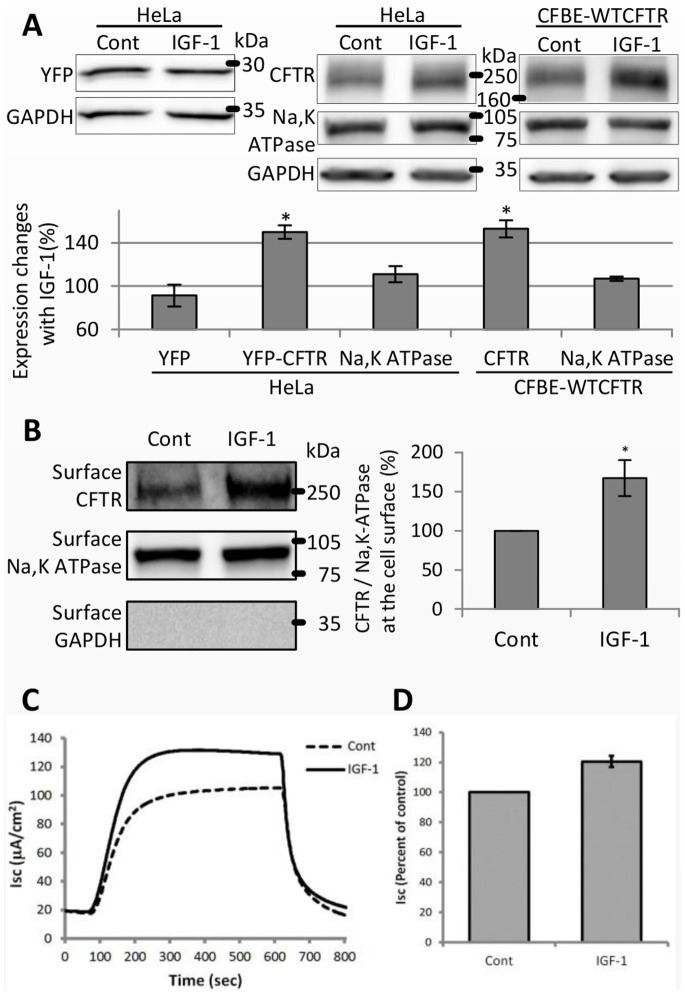
IGF-1 increases the protein expression level of CFTR and increases CFTR-mediated chloride transport in bronchial epithelial cells.(A) IGF-1 specifically increases the expression level of CFTR. HeLa cells were transfected with YFP or YFP-CFTR and incubated for one day, or confluent CFBE-WTCFTR cells were used. The graph in the right lower panel shows the expression of YFP, YFP-CFTR, CFTR, or Na,K-ATPase normalized by the GAPDH expression and normalized again by the corresponding control samples (%). (B) CFTR expression at the cell surface was increased by IGF-1 in HeLa cells. Proteins at the cell surface were cell surface-biotinylated. The graph in the right panel shows the expression of YFP-CFTR at the cell surface normalized by the Na,K-ATPase expression at the cell surface and normalized again by the corresponding control samples (%). (A,B) Cells were starved for 24 hours and then treated with 0.1 µg/ml IGF-1 for the next 24 hours. Results are means ±SE. (n = 3) (C) CFBE-WTCFTR cells grown on permeable supports were starved for 24 hours, then treated with 0.1 µg/ml IGF-1 for 24 hours. Cells were then mounted on the Ussing chamber setup, where short-circuit currents were measured as described in Materials and Methods. In the graph, 10 µM forskolin was added at the first arrow, and 5 µM CFTRinh-172 was added at the second arrow. (D) Ratio of ISC between cells treated with 0.1 µg/ml IGF-1 (IGF-1) and untreated cells (Cont). Error bars represent SE. (n = 5). *p<0.05 and **p<0.005.